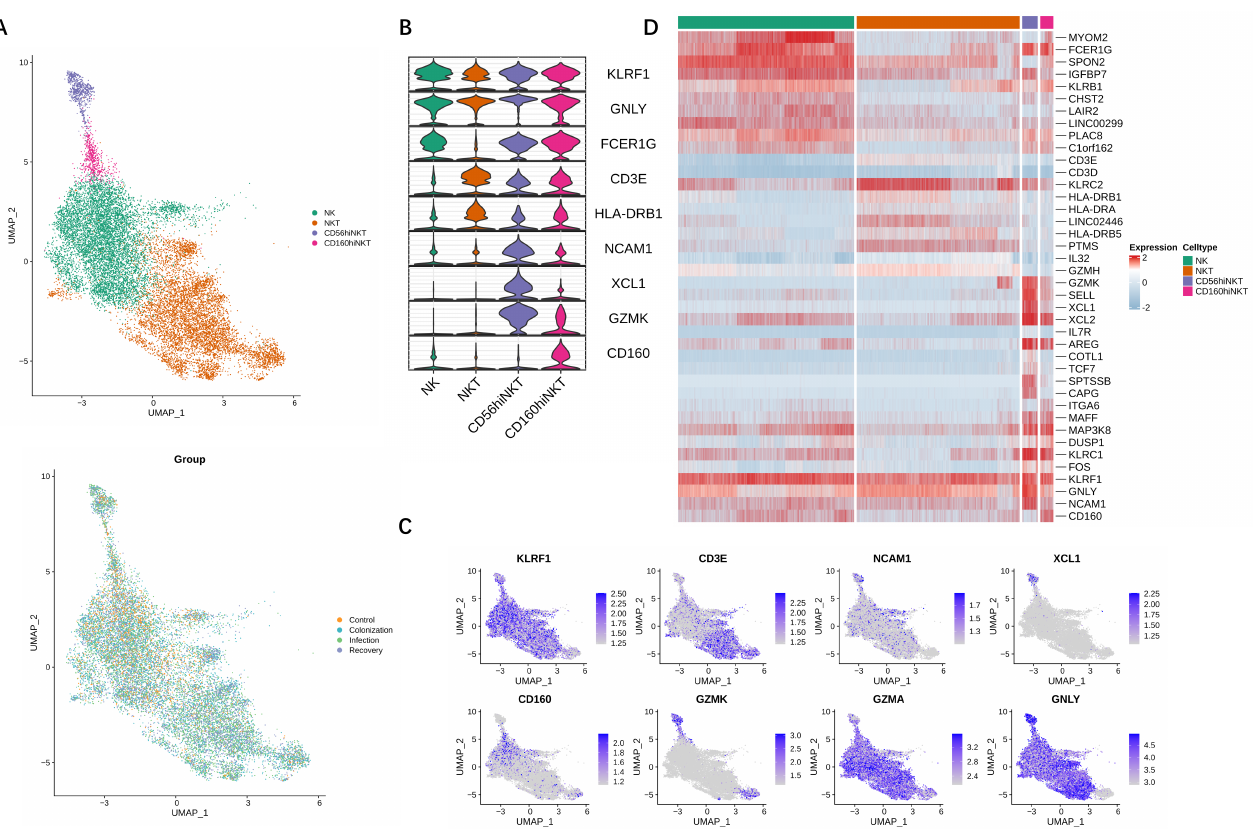
Figure 1. Circulating NK and NKT subset diversity during CRKP infection. ( A ) The UMAP visualiza- tion of individual cells from 10 PBMC samples taken from healthy donors ( n = 1) and patients across CRKP colonization ( n = 3), infection ( n = 3), and recovery ( n = 3). Each dot corresponds to a single cell, colored according to cell type ( upper ) and CRKP infection conditions ( lower ). ( B ) Violin plots showing the expression distribution of selected canonical cell markers in the four clusters. The rows represent selected marker genes and the columns represent clusters with the same color as in ( A ). ( C ) Canonical cell markers were used to label clusters by cell identity as represented in ( A ). Data are colored according to expression levels, and the legend is labeled in log scale. ( D ) Gene expression heatmap in each cell cluster of ( A